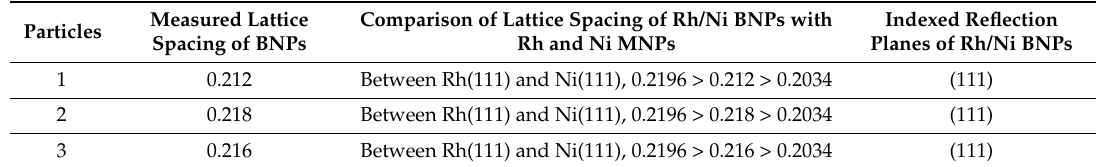
pH =14 pH =13 pH =12 Figure 6. Evaluation of H 2 productivity with reaction time of Rh 10 Ni 90 BNPs at different pH values ( R ISO = 40, C Metal = 0.66 mM, reduced under ice ‐ water bath for 1 h; 30 °C). The apparent activation energy ( E a ) of the BNPs for hydrogen generation from the hydrolysis of alkaline KBH 4 solution was calculated by using the Arrhenius method [9,17,27]. The catalytic activities of Rh 10 Ni 90 were enhanced with the increasing reaction temperature and a linear dependence between catalytic rates (in a logarithmic scale, ln k ) and the reciprocals of temperature was observed (as shown in Figure 7). According to the Arrhenius equation, the slope of the linear plot is − E a / R , where R represents the universal gas constant. Within the temperatures ranging from 303 to 323 K, E a was calculated to be 47.2 ± 2.1 kJ/mol for Rh 10 Ni 90 BNPs. These results suggest that the as ‐ prepared Rh 10 Ni 90 BNPs are excellent catalysts for the hydrolysis of KBH 4 because of their lower apparent activation energy compared with other reported catalysts, such as 51.2 kJ/mol for Co ‐ La ‐ Zr ‐ B NPs [28], 52.0 kJ/mol for Co ‐α Al 2 O 3 ‐ Cu catalysts [29], 55.6 kJ/mol for Co/alginate hydrogels [30], and 48.8 kJ/mol for Mo incorporated Co ‐ Ru ‐ B catalysts [31], etc.